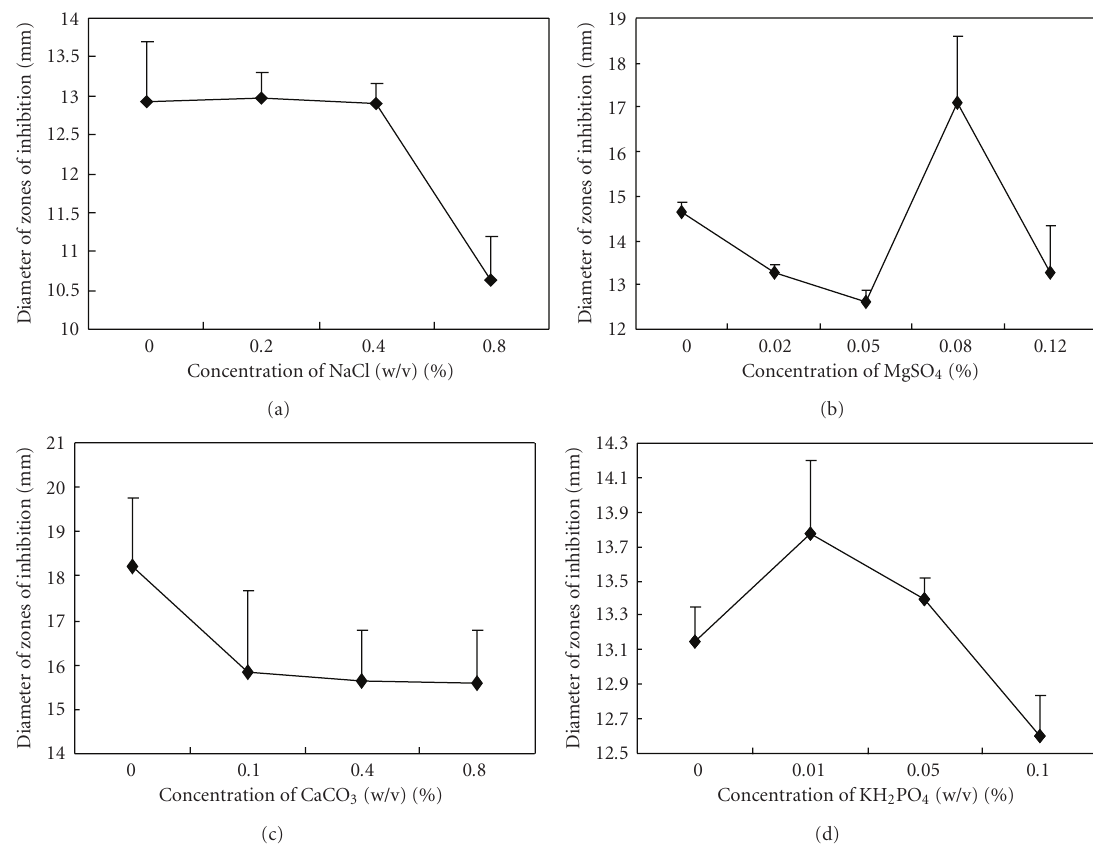
Figure 1: E ff ect of microelements at di ff erent concentrations on the production of antimicrobial active compounds in the fermentation supernatant of strain Hhs.015 T to Candida vulgaris on PDA. The antimicrobial activity was determined by measuring the translucent inhibition zones after incubating the dish 24 hours at 30 ◦ C. Apple pomace (1.5%w/v) and rapeseed meal (0.2%w/v) were used as